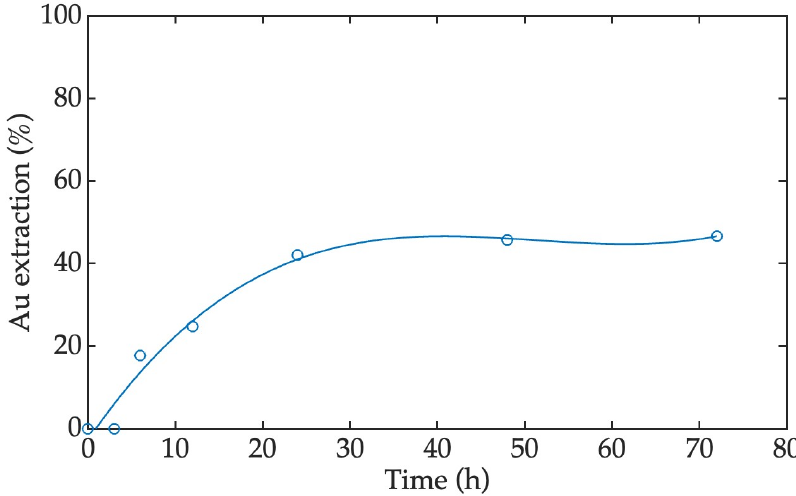
Figure 3. Au recovery (%) resulting from cyanidation at room temperature and atmospheric pres ‐ sure as a function of time.